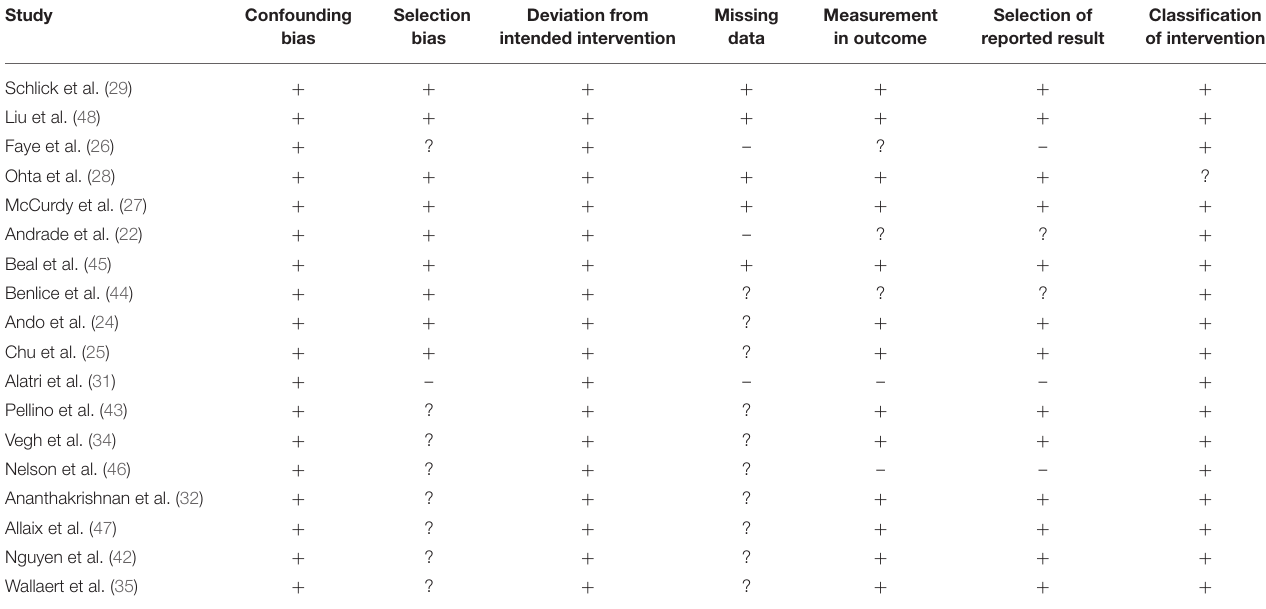
TABLE 2 | Demonstrates the risk of bias according to Cochrane’s risk of bias assessment tool for randomized controlled